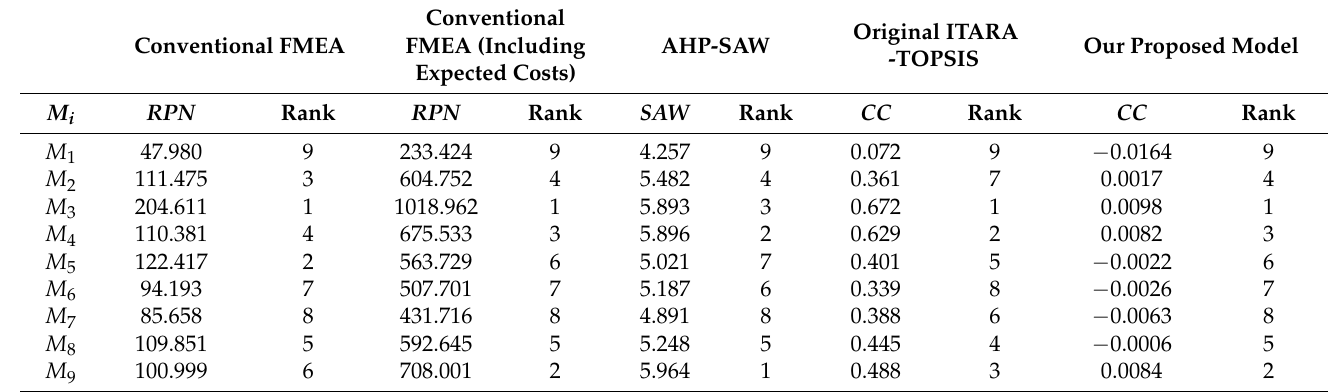
Table 13. Failure mode rankings of the five models.